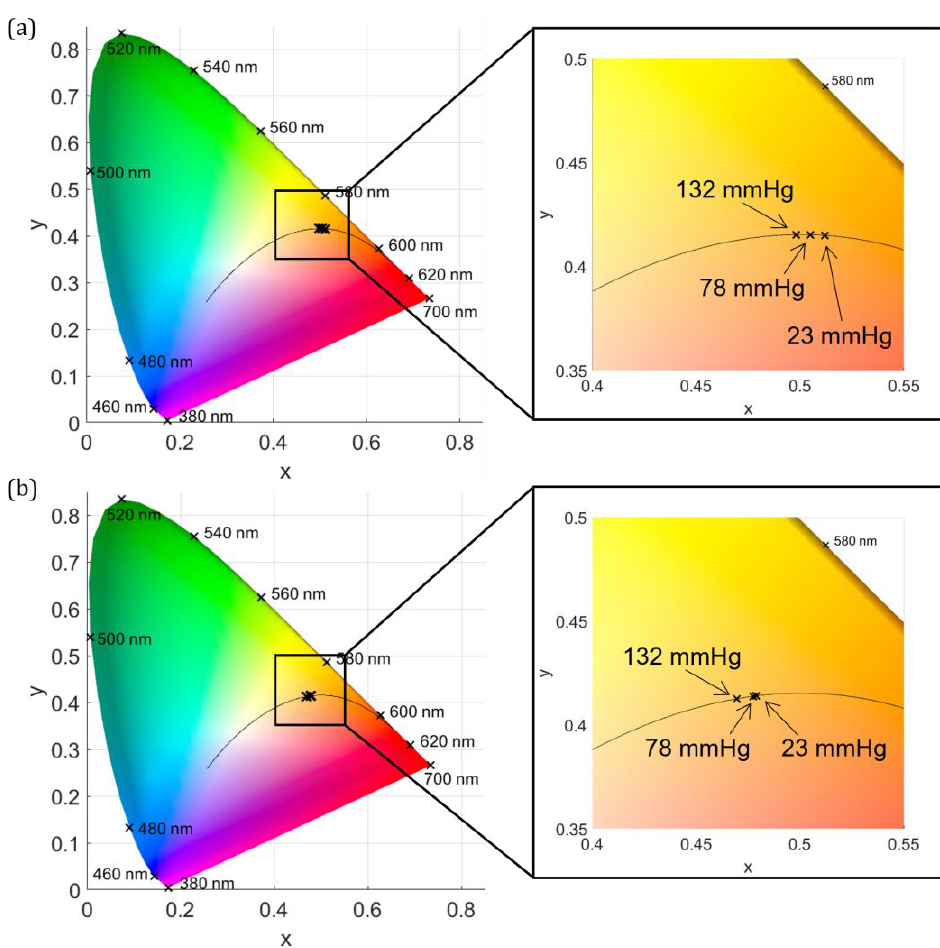
Figure 4. The CIE 1931 color space chromaticity diagram is illustrated ( left ) along with a zoom of the selected area ( right ). The CCT inside the eye during diaphanoscopic illumination is displayed for different applied pressures (23, 78, and 132 mmHg) for the halogen lamp ( a ) and the xenon lamp ( b ).